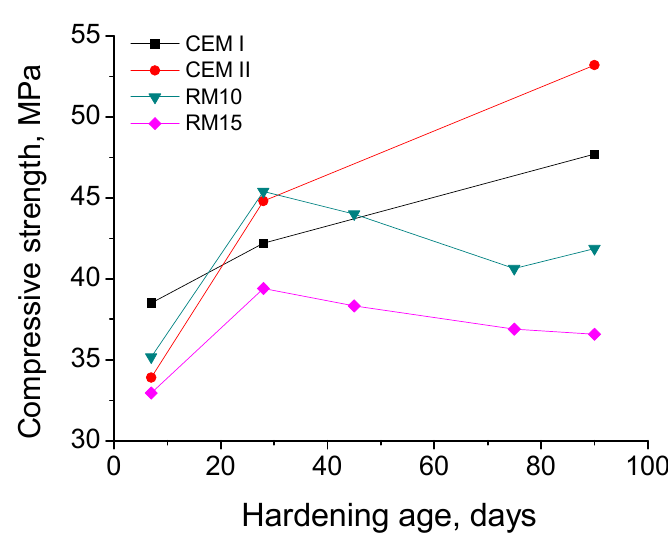
Figure 11. Results of compressive strength for CEM I, CEM II, RM10 and RM15 mortars.